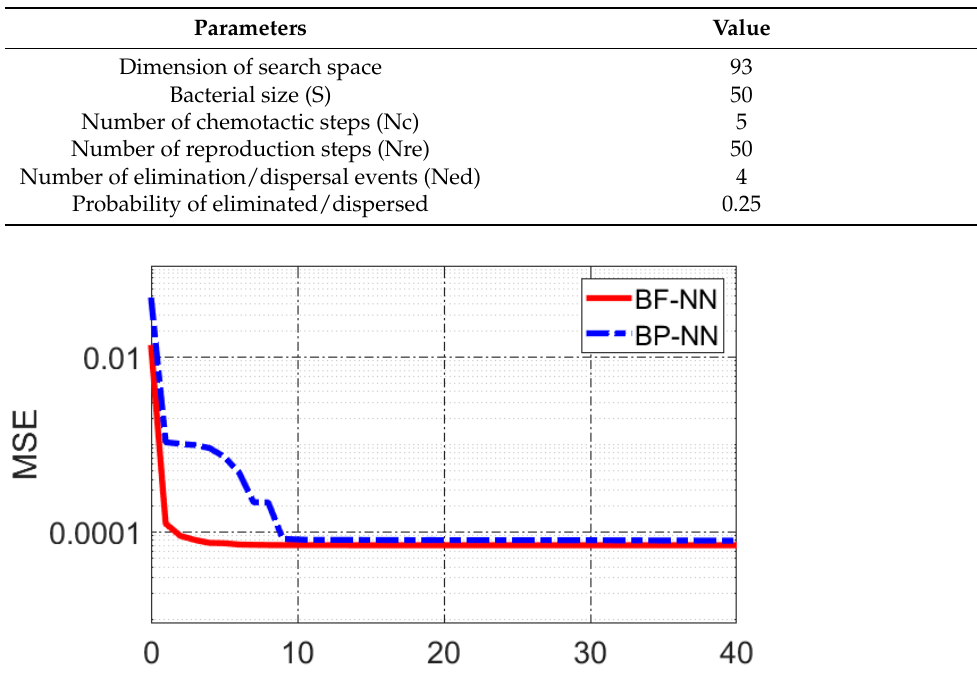
Table 3. Parameters of BF-NN algorithm.